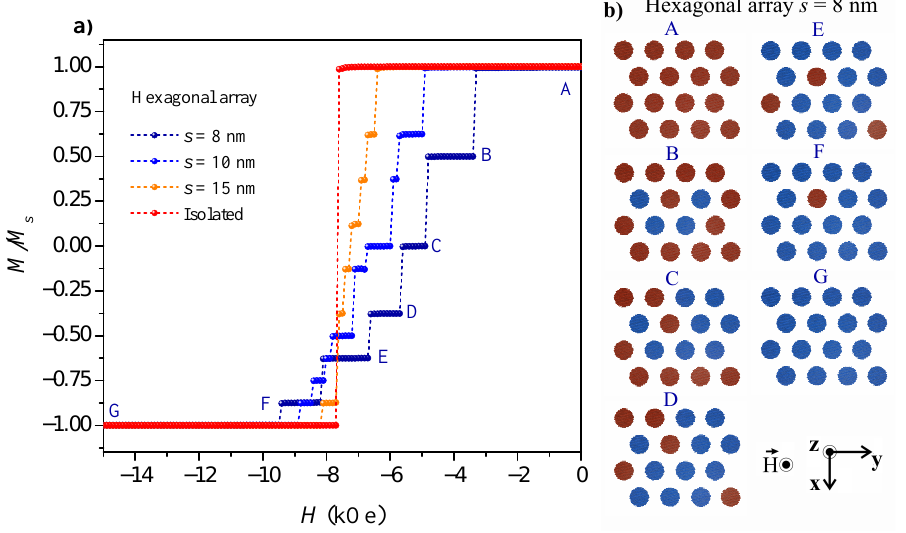
Figure 5. Hysteresis curves for hexagonal arrays of Fe cylindrical nanostructures with the aspect ratio h / d = 4, calculated for different distances between them ( a ). For comparison, a hysteresis loop was added for an isolated cylindrical nanostructure with the same aspect ratio. A cross-section through the top of the cylindrical nanostructures in hexagonal array ( h / d = 4) with distance s = 8 nm, showing the corresponding spin configurations during the remagnetization process ( b ). The configurations A and G correspond to saturation along Oz (red color) and -Oz (blue color) field direction, respectively, while configurations from B to F correspond to the intermediate magnetization states (see the text). All configurations are indicated on the corresponding M ( H ) curve.